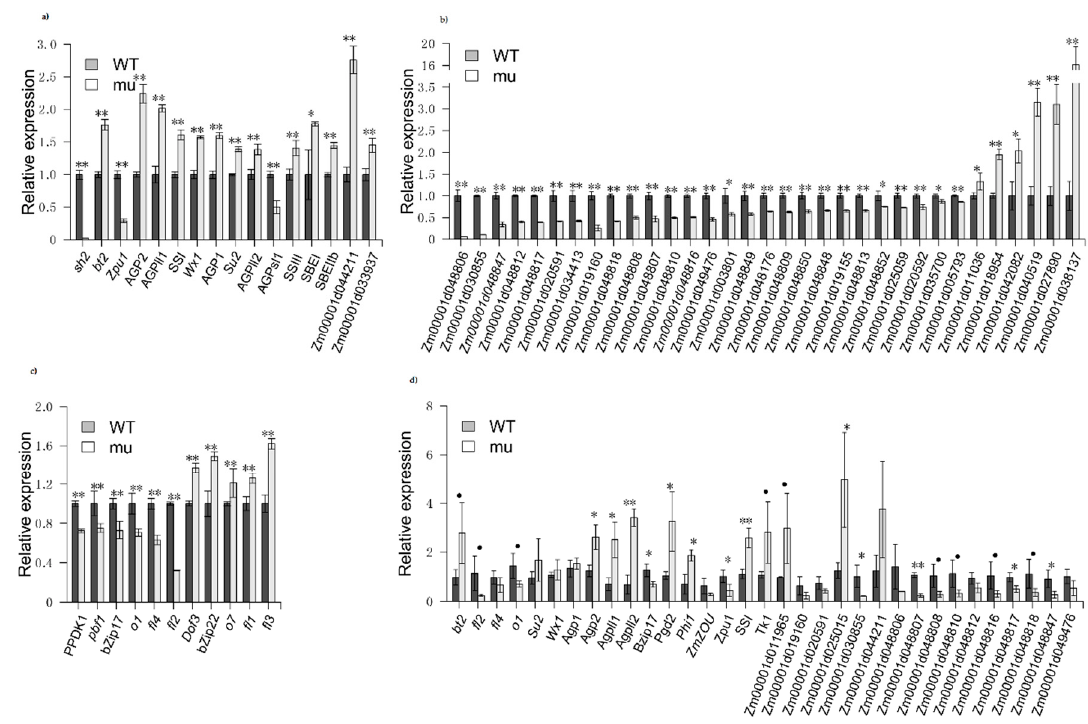
Figure 2. Expression levels of starch biosynthesis, zein and maize endosperm genes in sh2 mutant kernels (mu) and wild-type kernels (WT). ( a ) Genes related to starch biosynthesis based on RNA-seq data (FPKM values); ( b ) Zein-encoding genes based on RNA-seq data (FPKM values); ( c ) Endosperm genes based on RNA-seq data (FPKM values); ( d ) Results of qRT-PCR. All expression levels were normalized to that of the wild type. The data are from three biological replicates per sample and are presented as mean values ± SD. (Student’s t- test, “ • ” represents p -value < 0.1, “*” represents p -value < 0.05, “**” represents p -value < 0.01).